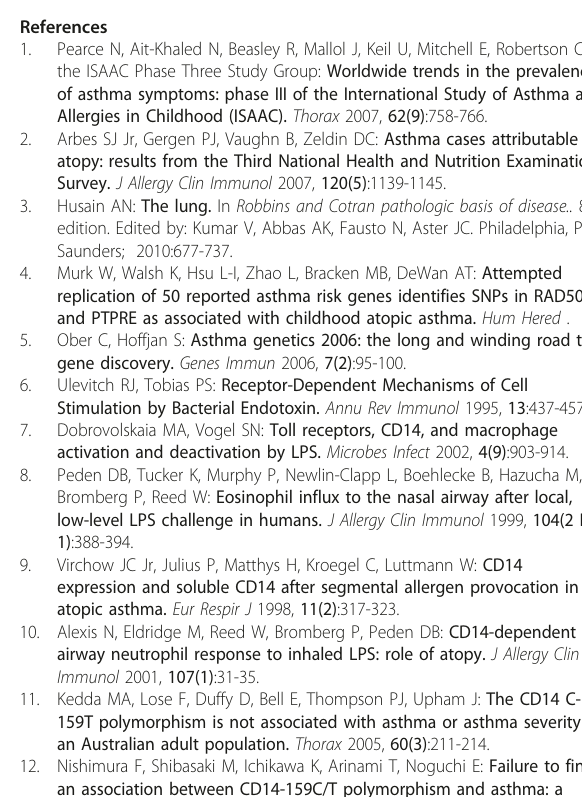
Additional file 7: Figure S5. Funnel plot of CD14 -260 ( -159 ) CT versus CC genotypes for studies with precisely defined phenotypes